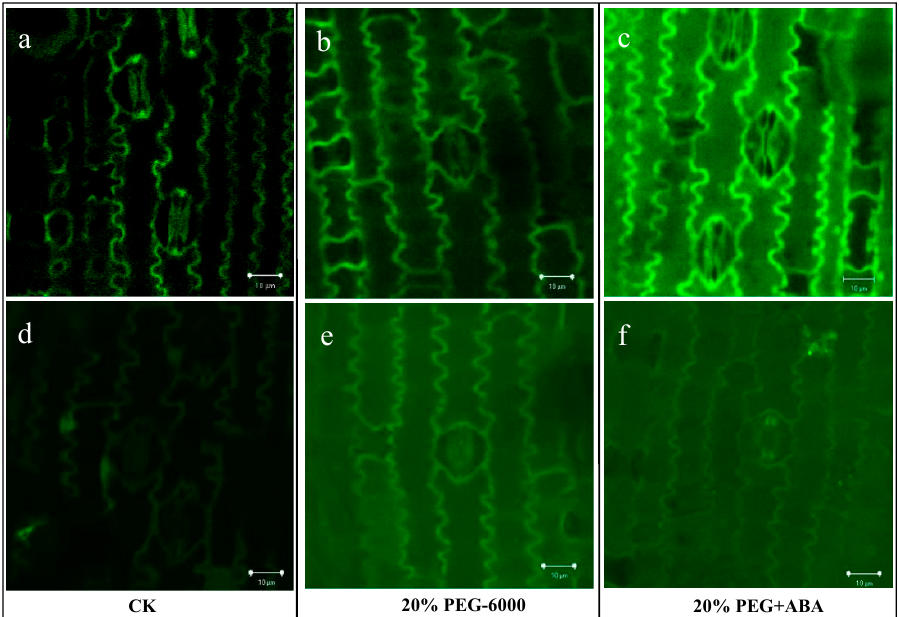
Figure 10. Localization of fluorescence of Ca 2+ and H 2 O 2 in mesophyll cells after application of exogenous ABA under drought stress. ( a ) Calcium-fluorescence localization of leaves of P. edulis seedlings with distilled water. ( b ) Calcium-fluorescence localization of leaves of P. edulis seedlings under 20% PEG 6000-induced stress for 10 min. ( c ) Calcium-fluorescence localization of leaves of P. edulis seedlings with the application of 30 µ mol/L ABA to 20% PEG-induced stress for 10 min. ( d – f ) H 2 O 2 fluorescence localization under the same treatment as above.